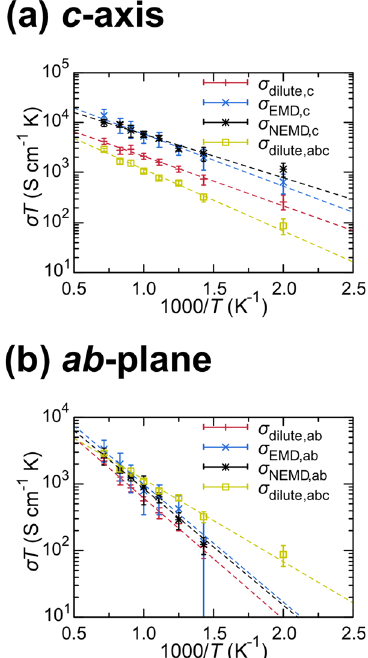
Fig. 4 Temperature dependence and anisotropy of ionic con- ductivity. Arrhenius plot of the σ T of LGPS a along c -axis and b in ab -plane. The values and error bars are the average and standard deviation of the fi ve independent samples with different initial velocities, respectively.